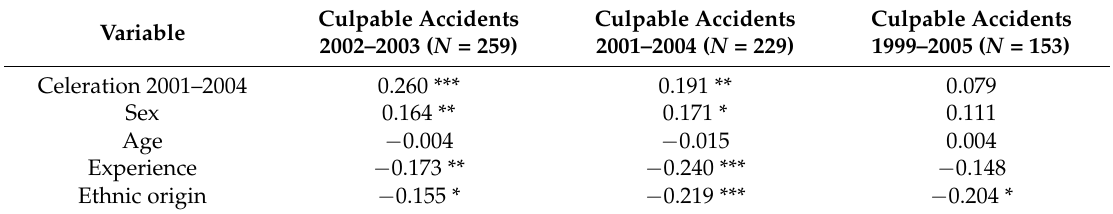
Table 2. The correlations of celeration, sex, age experience, and ethnic origin with culpable accident involvement in different time periods, for bus drivers at